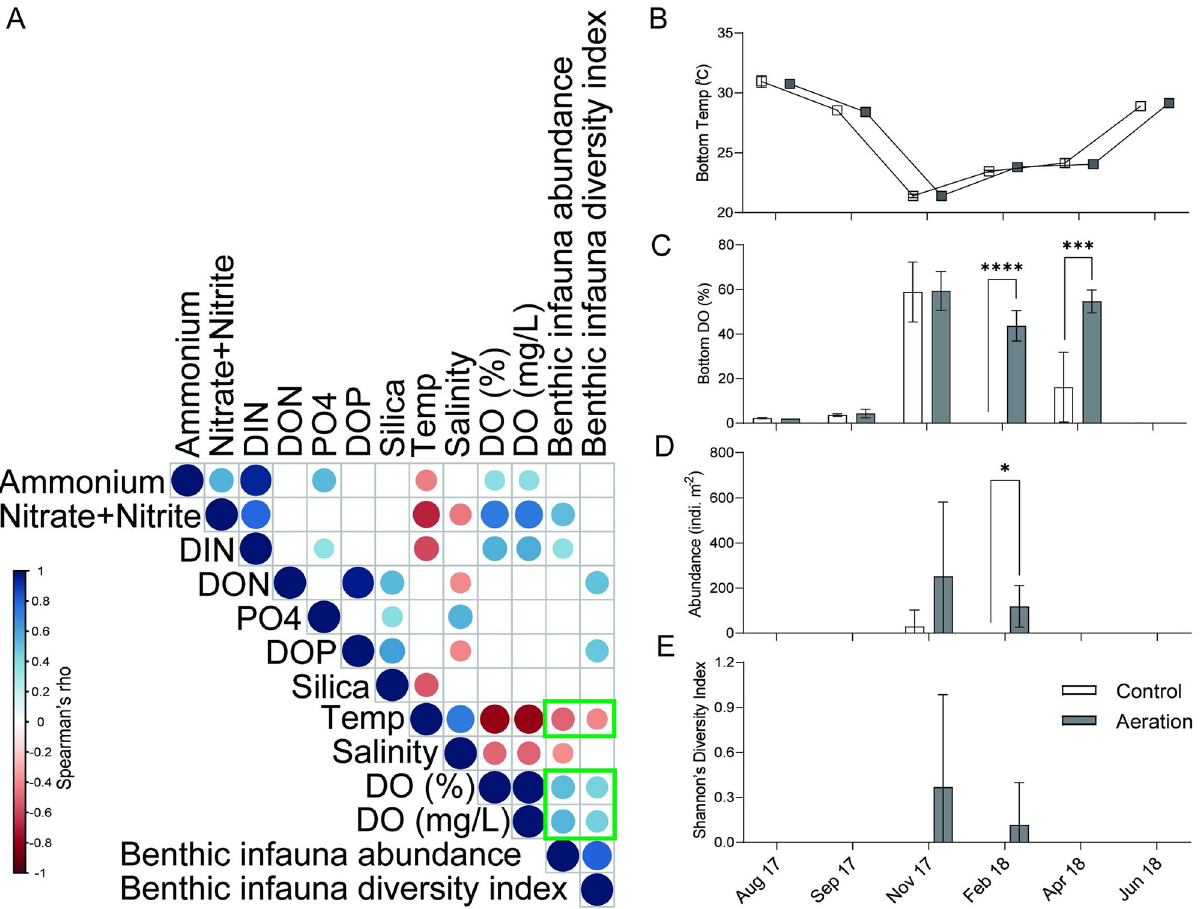
Fig 6. (A) Correlation analyses of benthic infauna community (both abundance and Shannon’s Diversity Index) and bottom water environmental parameters for all samples during the whole study period. The scale shows the degree of positive correlation (blue) or negative correlation (red) between two variables. Nonsignificant correlations (adjusted p > 0.05) are indicated by blanks. Green rectangles highlight the environmental parameters (Temperature and DO) that correlate to both benthic infauna abundance and Shannon’s Diversity Index. Comparisons of (B) bottom temperature (C) bottom DO (D) benthic infauna abundance (E) benthic infauna Shannon’s Diversity Index compared between the control and aeration canal in different months (2-way ANOVA and Fisher’s LSD post-hoc pairwise comparisons, where � p < 0.05, ��� p < 0.001, ���� p <